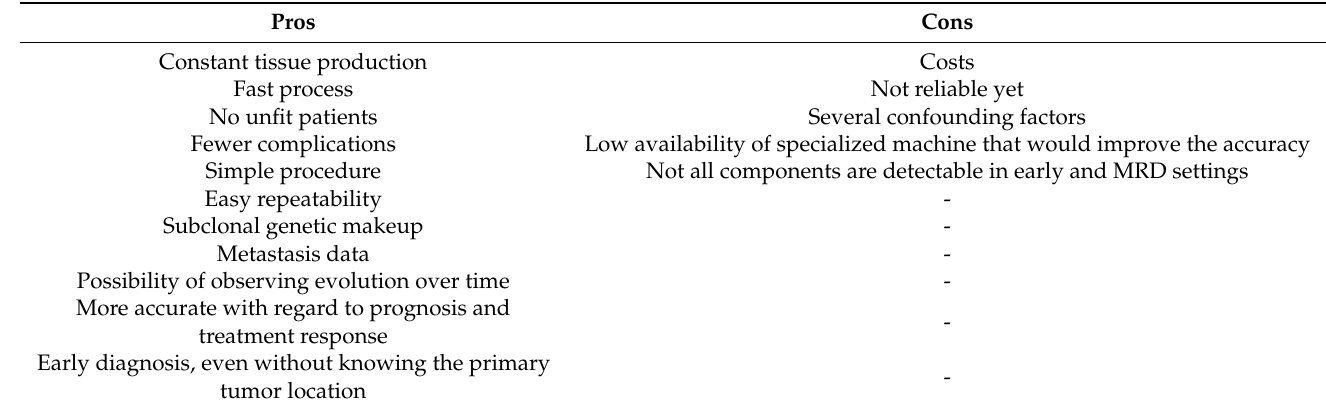
Table 1. Pros and cons of LBx compared to solid tissue